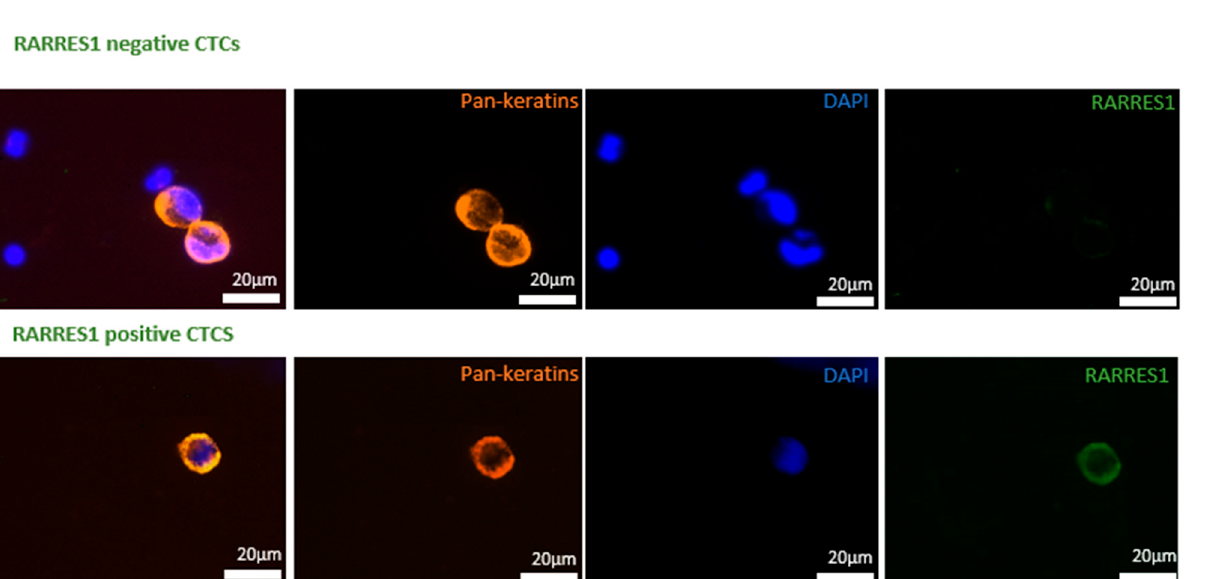
Figure 3. Kaplan-Meier curves of overall (OS) and recurrence-free (RFS) survival in primary tumor tissue and on CTC in PDAC patients. ( A ) OS based on RARRES1 protein expression data of tumor